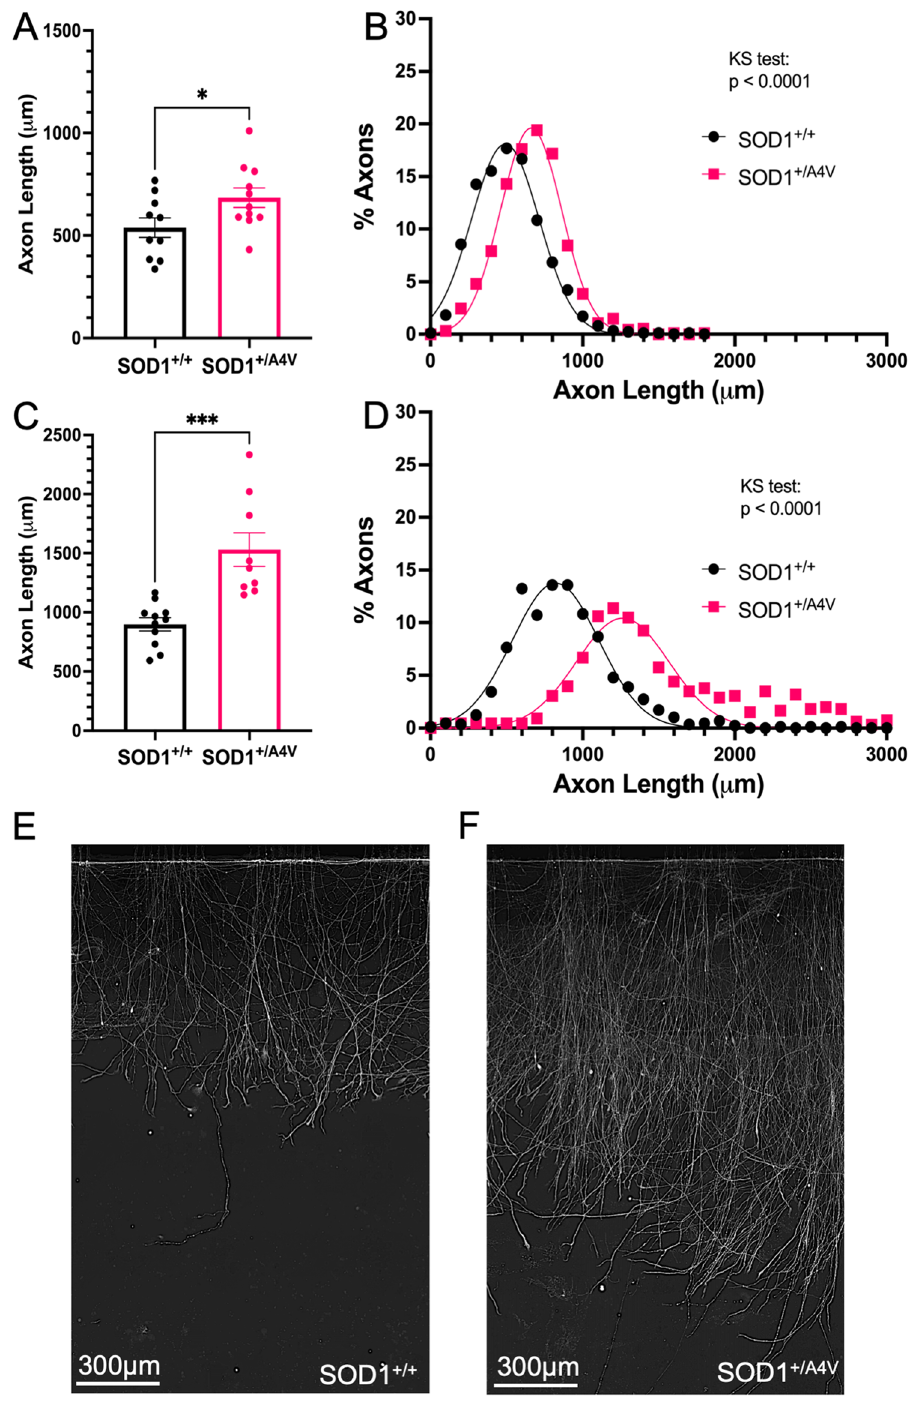
Figure 4. Enhanced regeneration of SOD1 +/A4V mutant axons. ( A ) Mean axon length 48 h post-axotomy (SOD1 +/+ n = 10; SOD1 +/A4V n = 11). *indicates p = 0.0438. ( B ) Frequency distribution of axon length. ( C ) Axon length 5 days post-axotomy. ( D ) Mean axon length 5 days post-axotomy (SOD1 +/+ n = 11; SOD1 +/A4V n = 9). *** indicates p = .0003. ( E ) Frequency distribution of axon length 24 h. Each data point on bar graphs ( A , C ) represents 50–100 traced axons from 1 individual axonal compartment. Bars represent mean ± SEM. ( D – E ) Representative images of regenerating axons 5 days post axotomy SOD1 +/+ ( D ) SOD1 +/A4V ( E